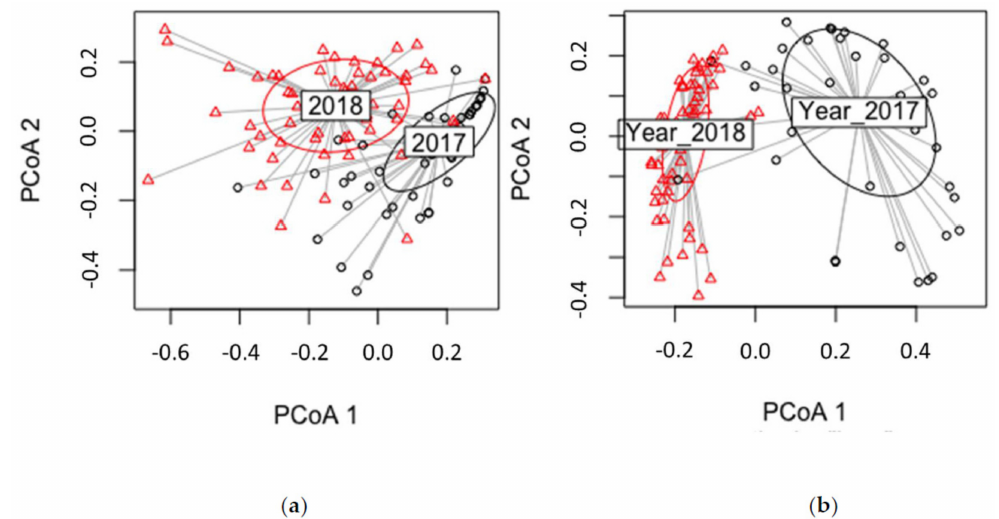
Figure 8. Dispersion of species in the culture-based isolation data ( a ) and OTUs in the HTS data ( b ) between growth years 2017 (black) and 2018 (red).